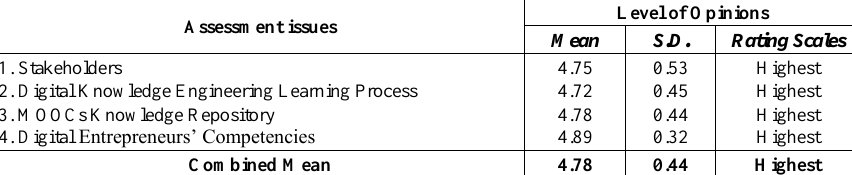
Table 10. Overall results regarding the assessment of the learning